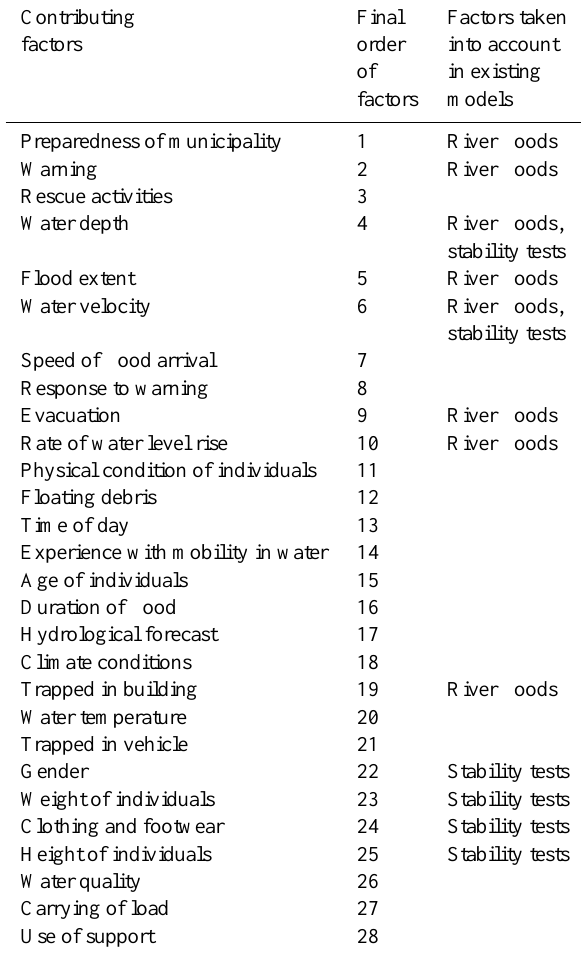
Table 4. Overall assessment of contributing factor